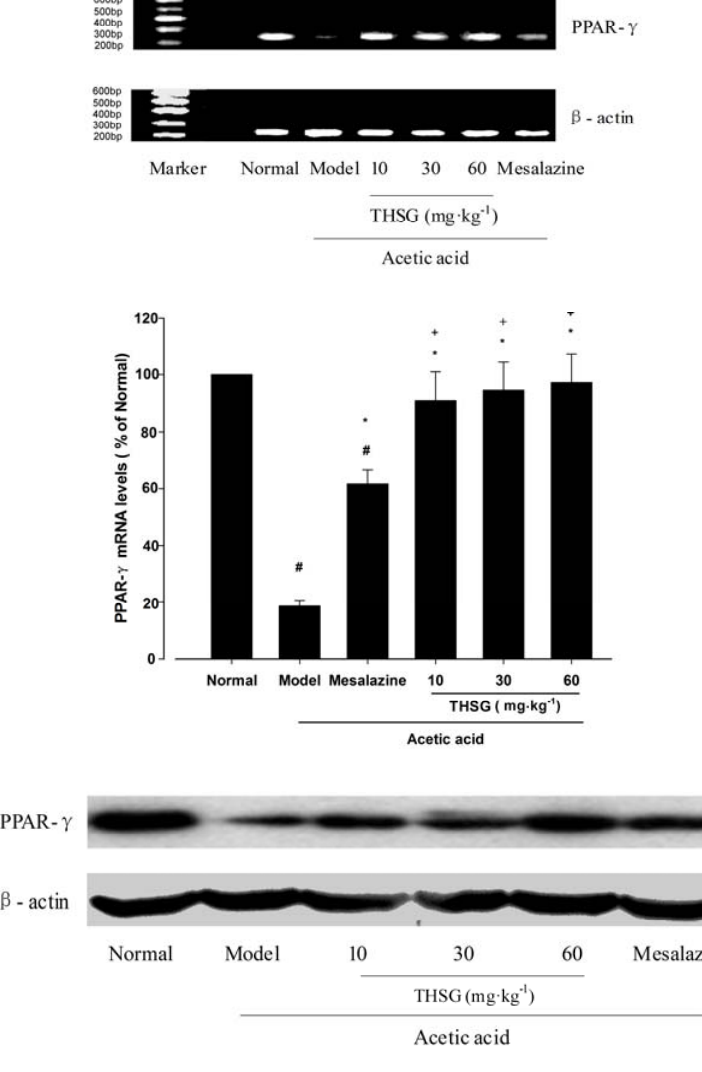
Figure 7. Effects of THSG on PPAR- γ mRNA and protein expression levels in colonic tissues treated with acetic acid. ( A ) RT-PCR analysis of products PPAR- γ and β -actin. ( B ) Histogram representing the quantitative analysis of PPAR- γ mRNA levels compared to the control after normalization to β -actin. ( C ) Immunoreactive bands of PPAR- γ and actin using specific antibody. PPAR- γ protein expression was assessed by Western blot